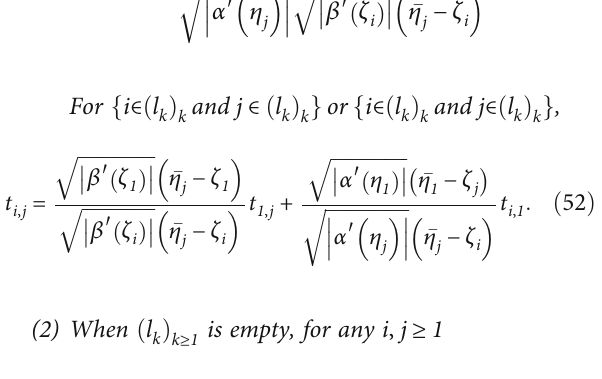
ffiffiffiffiffiffiffiffiffiffiffiffiffiffiffiffi (cid:12) β ′ ζ ð Þ (cid:12) 1 ffiffiffiffiffiffiffiffiffiffiffiffiffiffiffi (cid:12) β ′ ζ ð Þ (cid:12) i